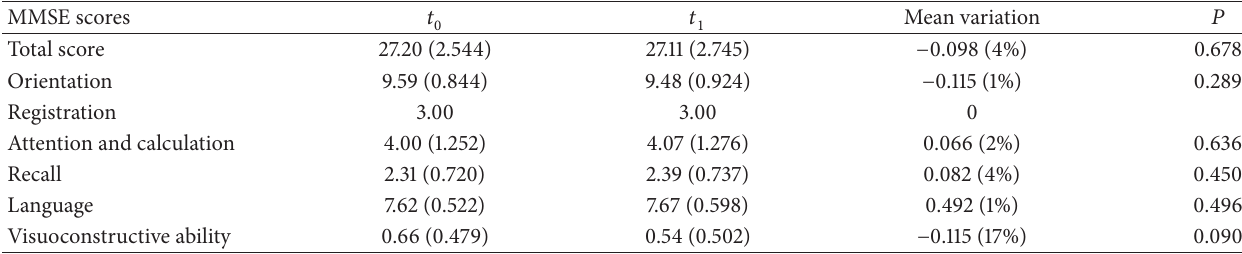
Table 2: Mini-mental state examination scores’ variation.